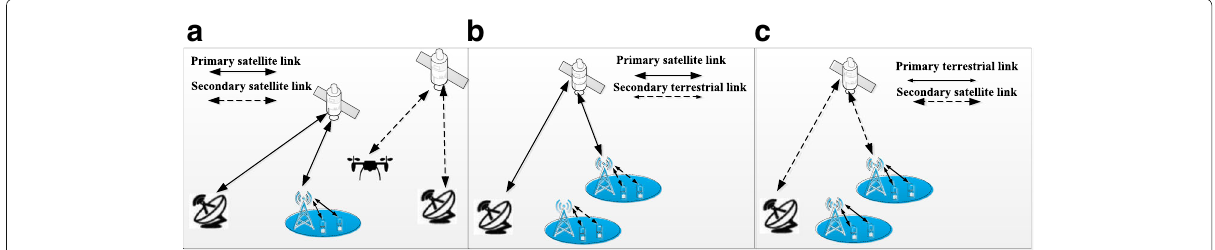
Fig. 2 Typical spectrum sharing scenarios in space information networks. ( a ) Spectrum sharing between a primary satellite system and a secondary satellite system. ( b ) Spectrum sharing between a primary terrestrial communication system and a secondary satellite system. ( c ) Spectrum sharing between a primary satellite system and a secondary terrestrial communication